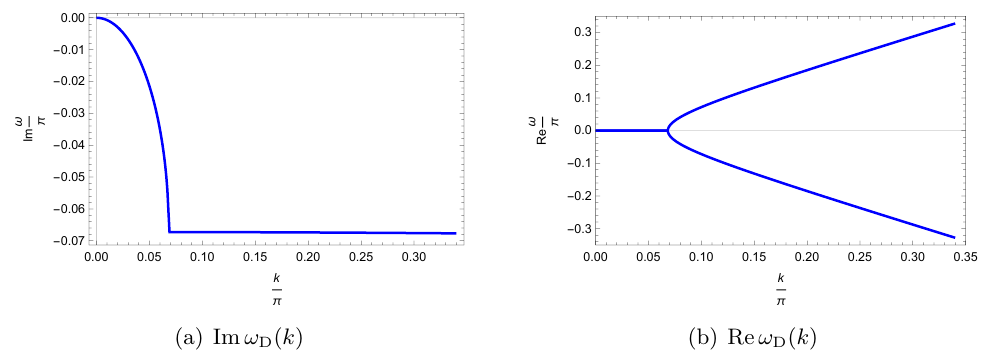
Figure 4 . Re ω D ( k ) and Im ω D ( k ) at ˆ β = 0 . 15 . As the value of k is increased, the diffusive behavior of ω D ( k ) with Re ω D ( k ) = 0 stops at k = k ∗ ≈ 0 . 07 π when the collision with the ω Q pole takes place and a pair of complex quasinormal modes are produced. For k > k ∗ , Im ω D ( k ) remains almost constant while Re ω D ( k ) ≈ | k − k ∗ | 1 / 2 when k is close to k ∗ . At higher values of k , Re ω D ( k ) is linear in k with slope very close to 1